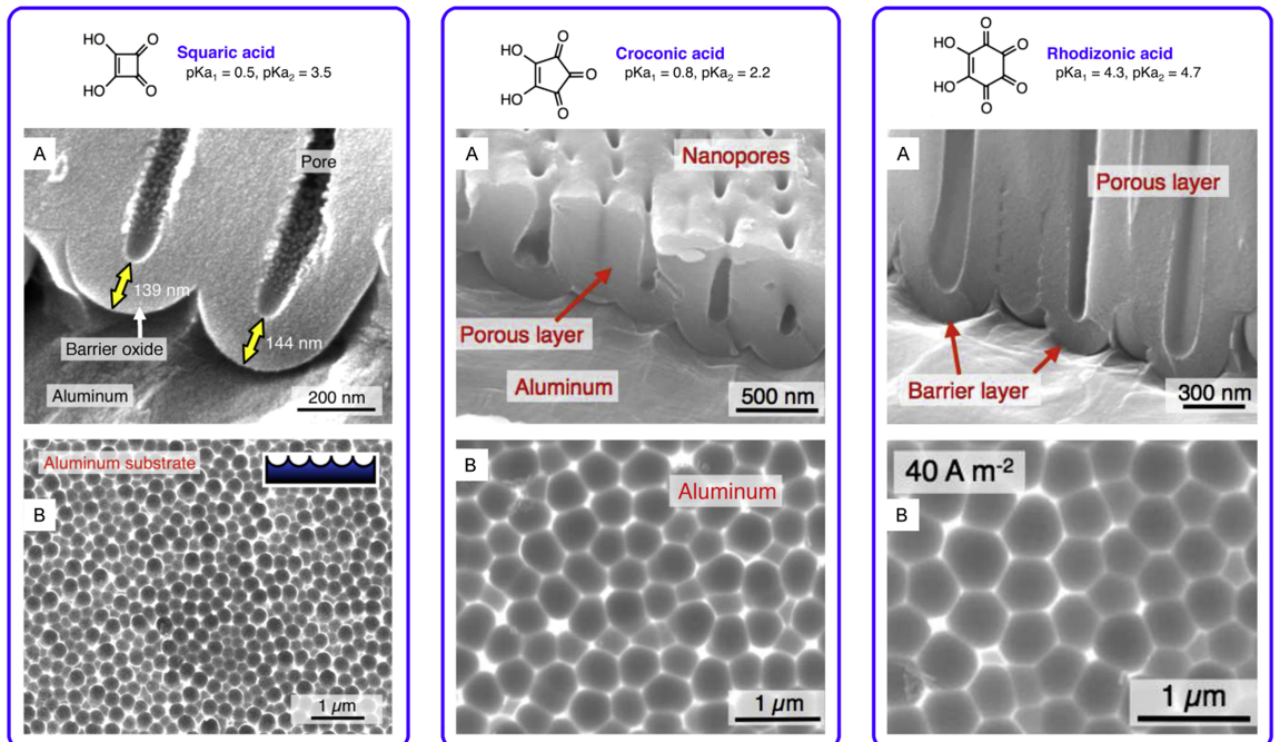
Figure 4. Examples of PAA laminas synthesized using cyclic oxocarbon acids (Kikuchi et al., [60,86]). From left to right: SEM images demonstrating the morphological features of PAA formed in squaric acid (via potentiostatic anodizing at 100–120 V), croconic acid, and rhodizonic acid solutions (via galvanostatic anodizing at 20–40 A m − 2 ). In each case, cross-sectional views of PAA are labeled as ( A ), and the micrographs showing arrays of shallow dimples remaining on the metal surface after the selective removal of PAA using a CrO 3 /H 3 PO 4 solution are labeled as ( B ). Adapted with permissions. Copyright 2014 Elsevier.